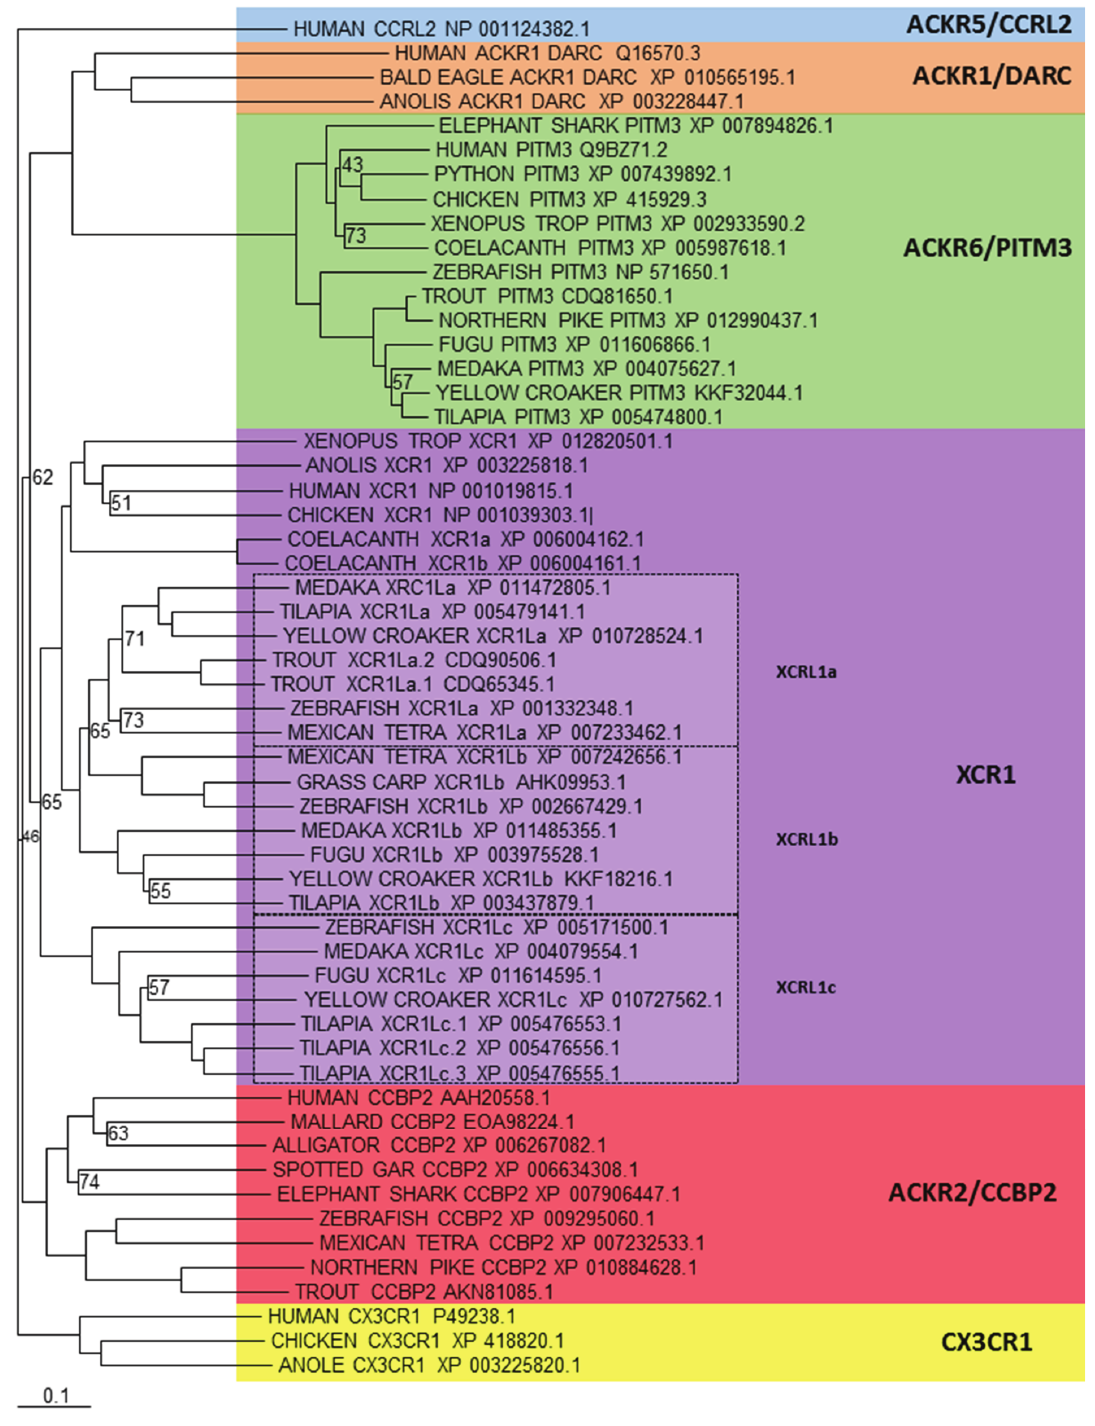
Figure 5. Phylogenetic analysis of human XCR1, CX3CR1, ACKR1 (DARC), ACKR2 (CCBP2), ACKR5 (CCRL2) and ACKR6 (PITPNM3) amino acid sequences with identified teleost, reptile, bird, amphibian and cartilaginous fish sequences. Sequences were found and trees generated as described in Figure 1. A different colour is used to indicate the clear clustering of sequences into each receptor group. Boxed regions indicate where there has been an expansion of a particular receptor, within